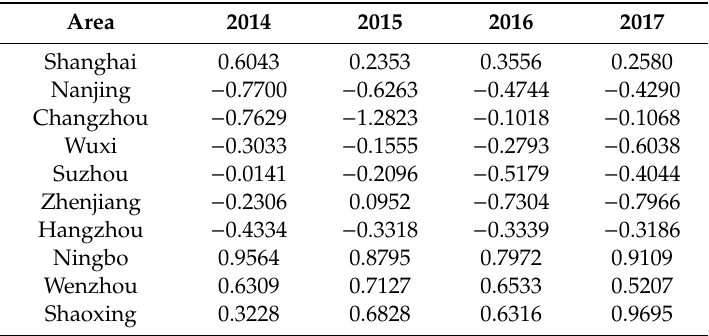
Table 7. The value of net